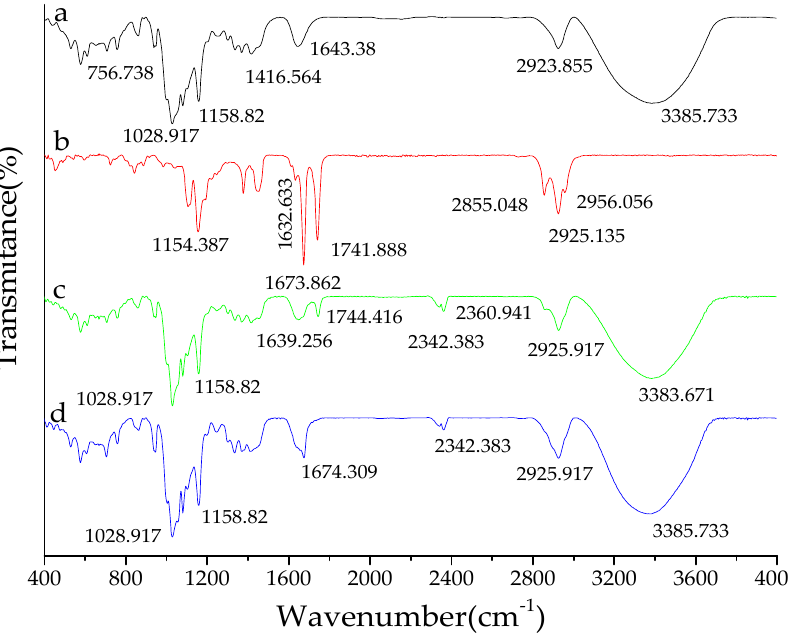
Figure 4. FT-IR spectra of β -CD ( a ), LCEO ( b ), the physical mixture ( c ), and the LCEO / β -CD inclusion complex (LCEO / β CD-IC) ( d ).